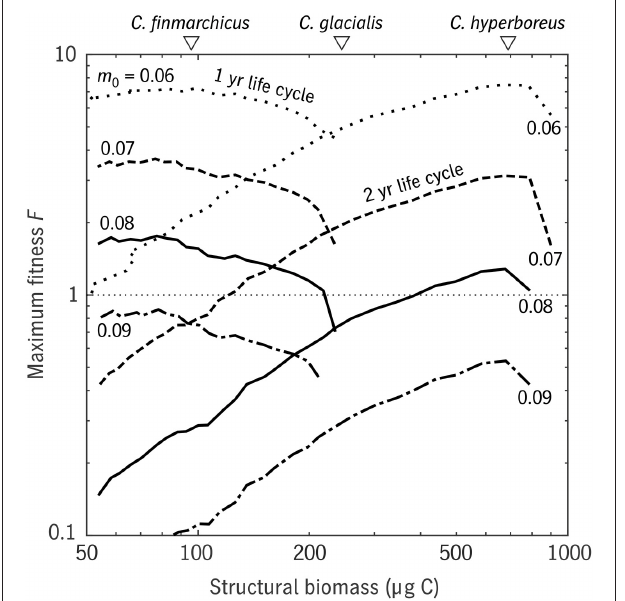
FIGURE 9 | Results of the ϕ model for a range of u 0 (relative development rate) values in the Disko Bay testbed (Figure 8). Maximum egg fitness F is plotted for 1-year and 2-year strategies, for each of four values of the mortality scaling parameter m 0 (0.06–0.09 d − 1 ), as a function of adult size S . The mean structural weights of the three Calanus spp. that coexist in Disko Bay are also shown (white triangles, top). Curves of F are shown over ranges where survival to adulthood without starvation is possible.